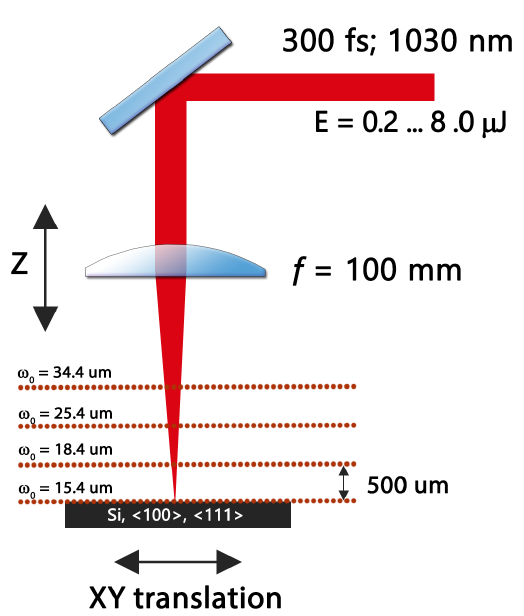
Figure 1. Experimental setup of single-pulse femtosecond laser processing of silicon surface.